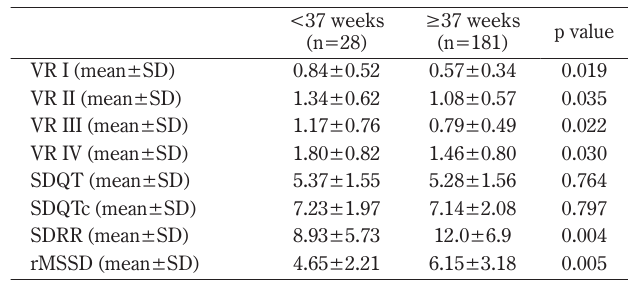
Table 5 Comparison of variability ratios stratified by gestational